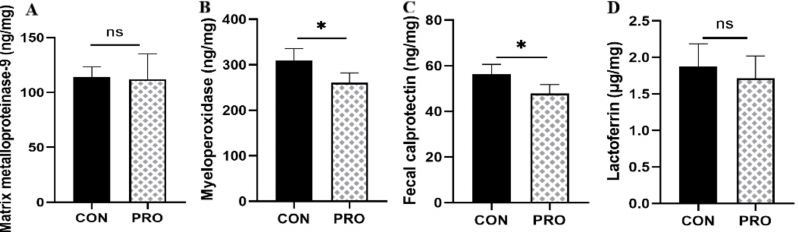
Figure 7. Effect of a multistrain probiotic preparation on inflammatory markers in feces in healthy short-haired domestic cats. ( A – D ) Concentrations of matrix metalloproteinase-9 ( A ), myeloperoxidase ( B ), calprotectin ( C ), and lactoferrin ( D ) in feces. Data are presented as mean ± SD. * p < 0.05; ns, p > 0.05 compared with the control group.